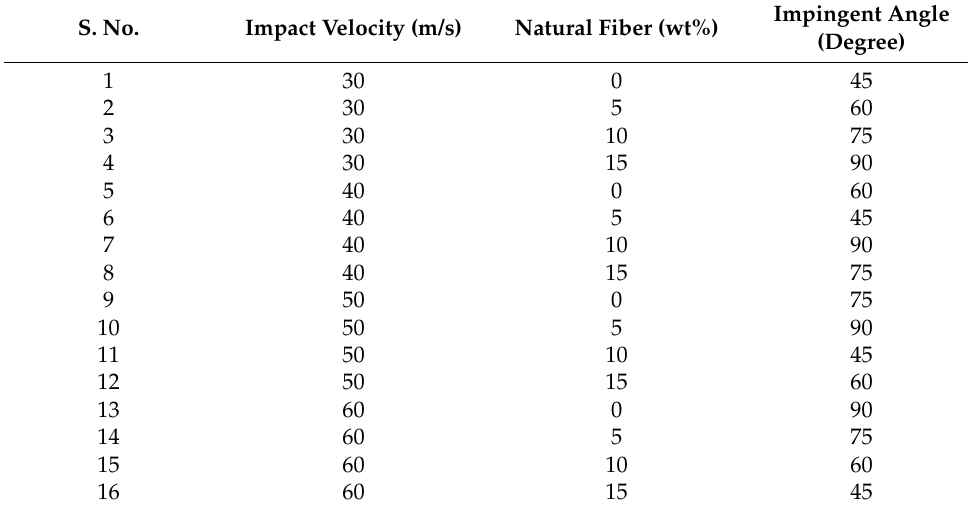
Table 3. Design-matrix array